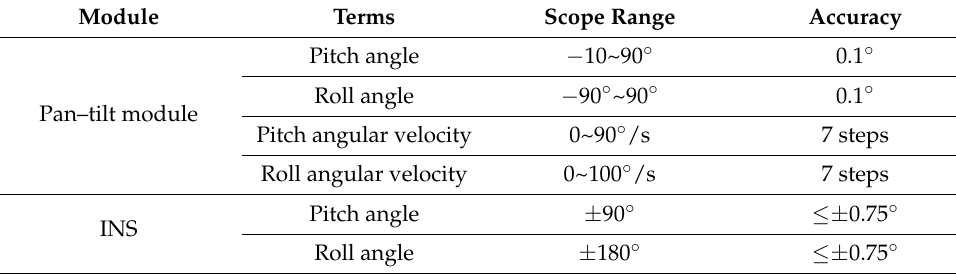
Table 6. Range of the parameters in the control system.